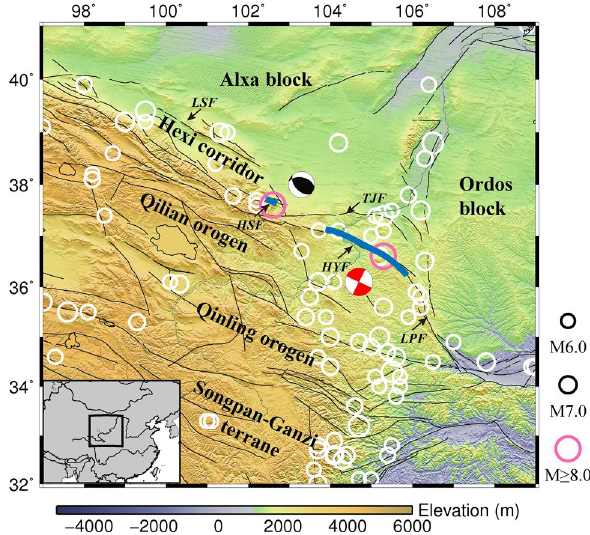
Figure 1. Tectonic background of the NE Tibetan Plateau and its surrounding areas. The white circles denote the locations of earthquakes larger than magnitude 6.0 and their sizes are proportional to magnitude. The two pink circles represent the 1920 Haiyuan M 8.5 earthquake (on the right) and 1927 Gulang M 8 earthquake (on the left), respectively. The two thick blue lines show the rough surface rupture zones of these two large earthquakes 23,24 , while their focal mechanisms are displayed by the two nearby beach balls respectively 23,25 . The black thin lines illustrate the main active faults 26 , among which the major ones are abbreviated as followings: LSF, Longshoushan fault; HSF, Huangcheng-Shuangta fault; TJF, Tianjingshan fault; HYF, Haiyuan fault; LPF, Liupanshan fault. The maps are created using Generic Mapping Tools (GMT) 27 (v.4.2.1, https ://www.gener ic-mappi ng-tools